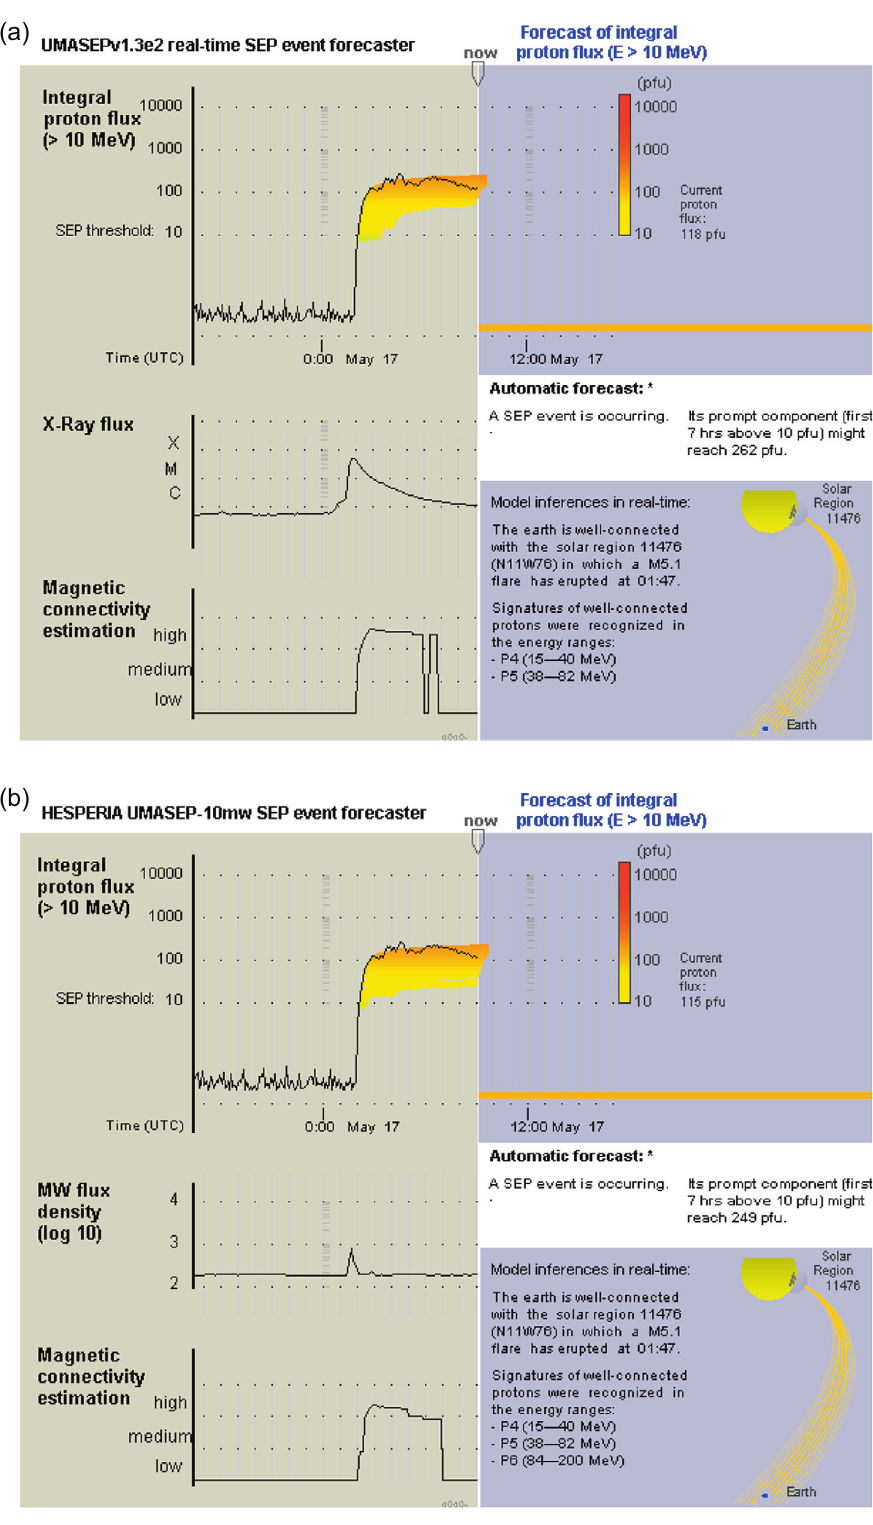
Fig. 9. UMASEP prediction web page for 2012 May 17: (a) and (b) show the SEP prediction using soft X-rays and microwaves,